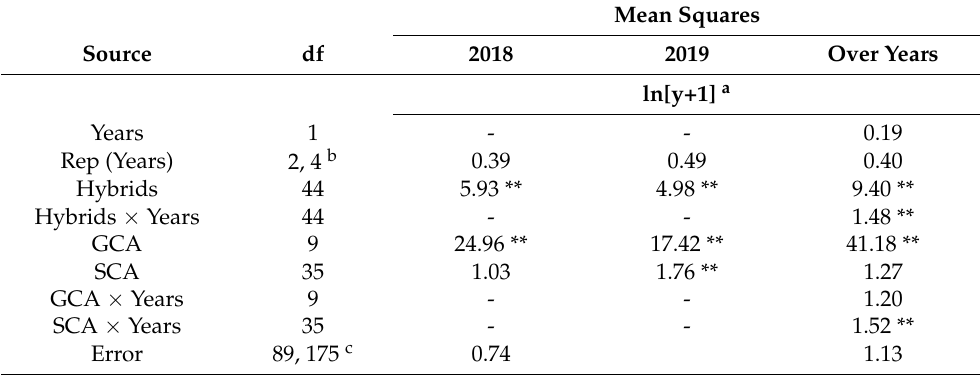
Table 3. Diallel analysis of variance for aflatoxin contamination over and within years.